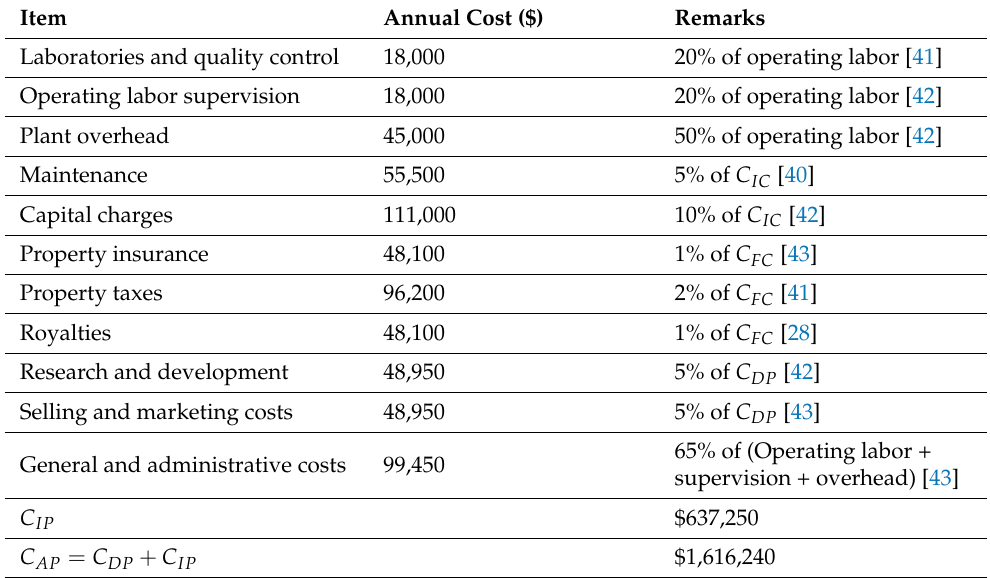
Table 5. Indirect production cost ( C IP ) of a 1000 t/y DSO biodiesel production